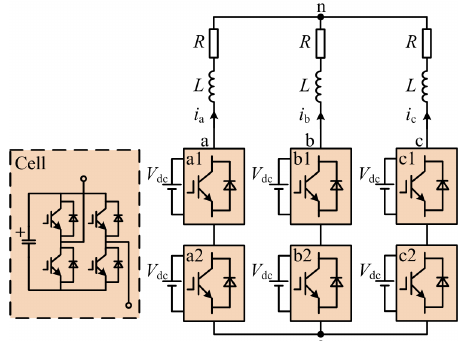
Figure 1. The topology of the five-level cascaded H-bridge inverter.